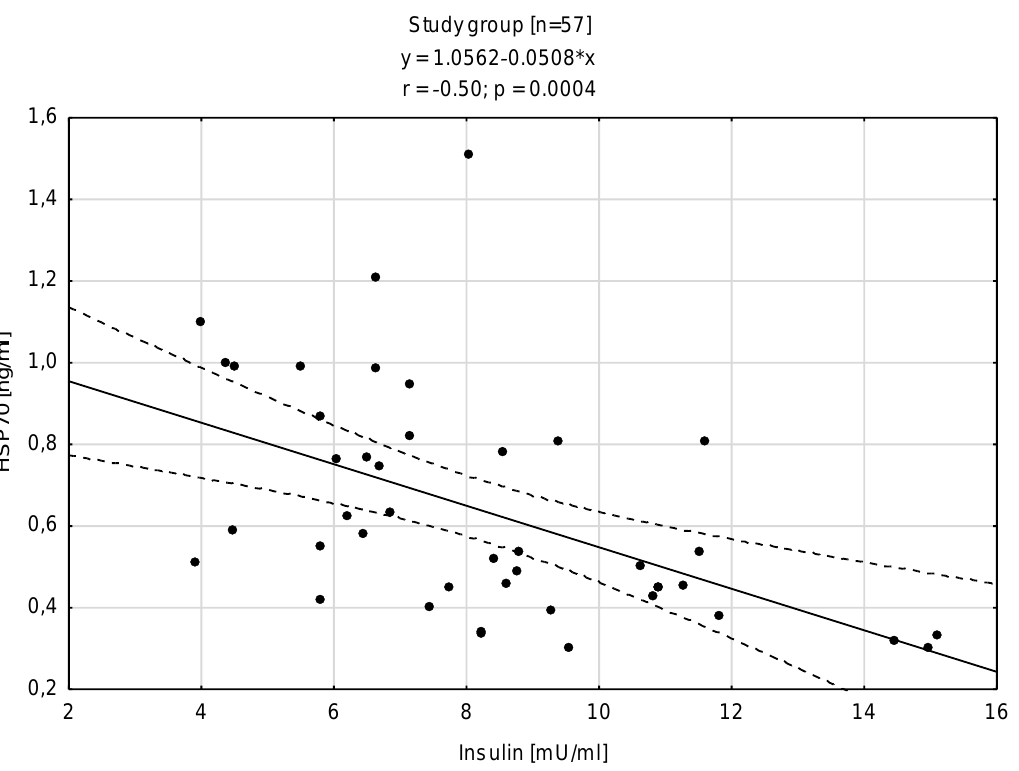
Figure 4. Relationship between the concentration of HSP70 and insulin concentration in the blood serum.